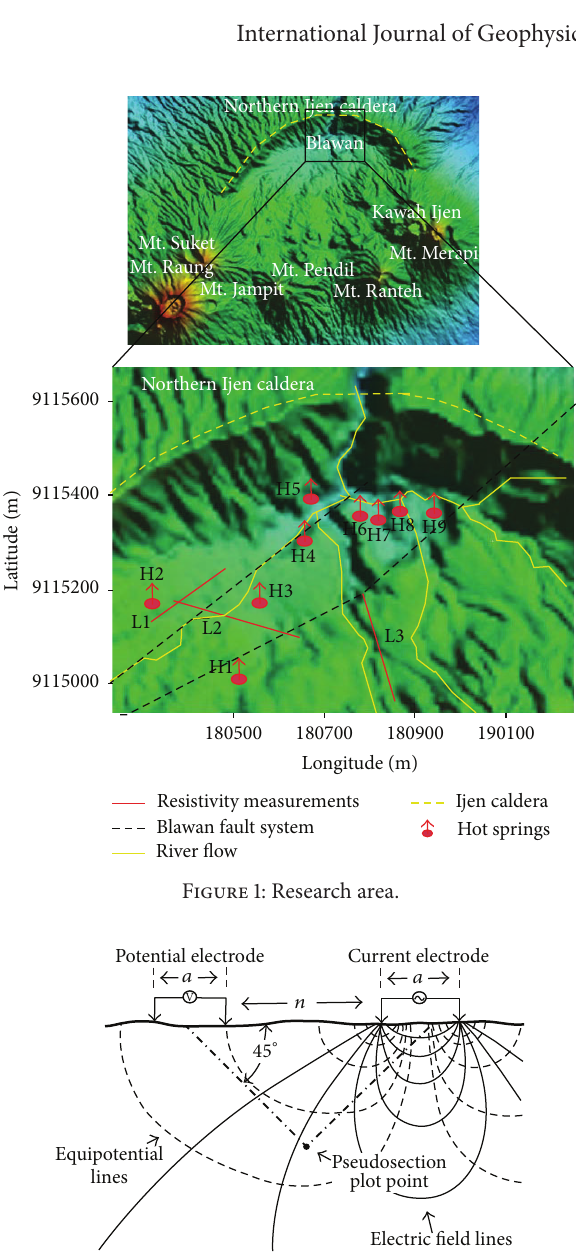
Figure 2: Dipole-dipole configuration